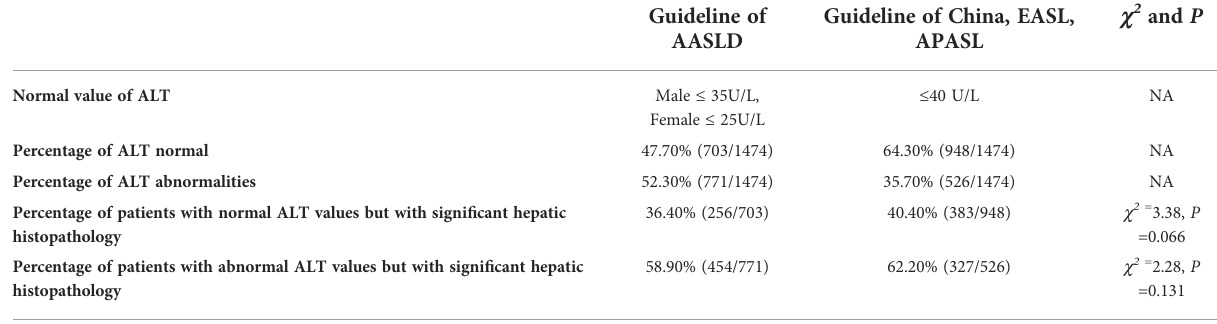
c 2 and P Guideline of Guideline of China, EASL, AASLD APASL